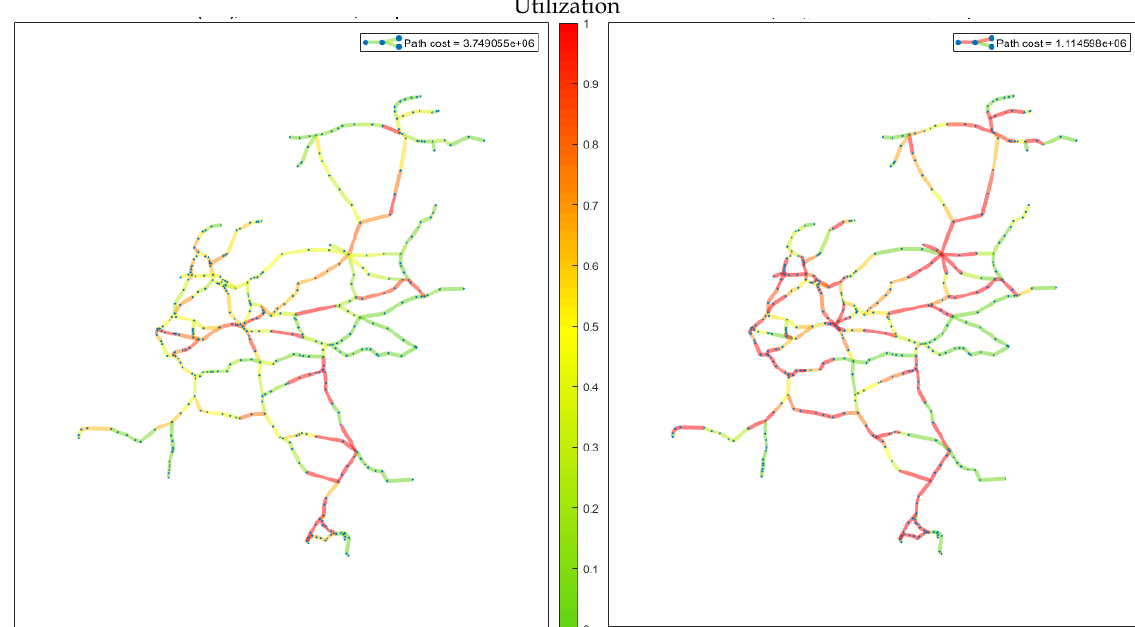
Figure 5: Link Utilization of 100% Demand Share in normal and covid19